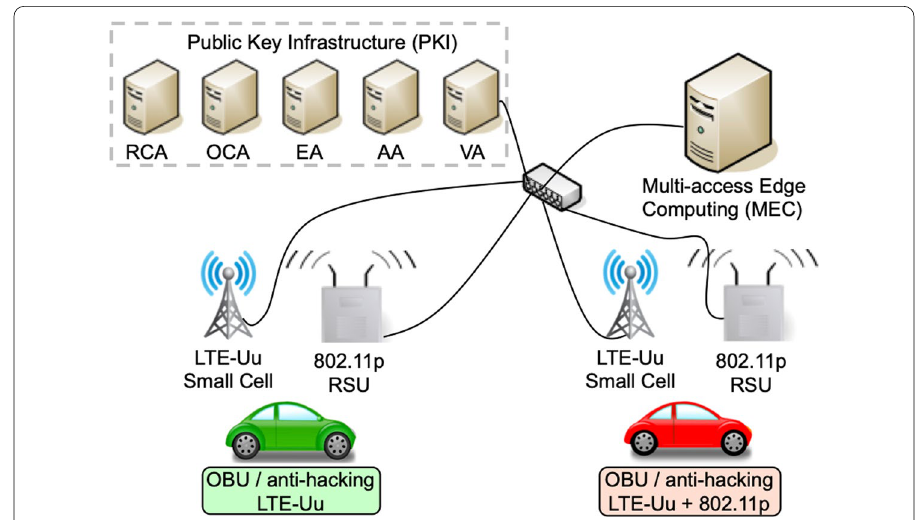
Fig. 1 Secure multi‑technology V2X telecommunications